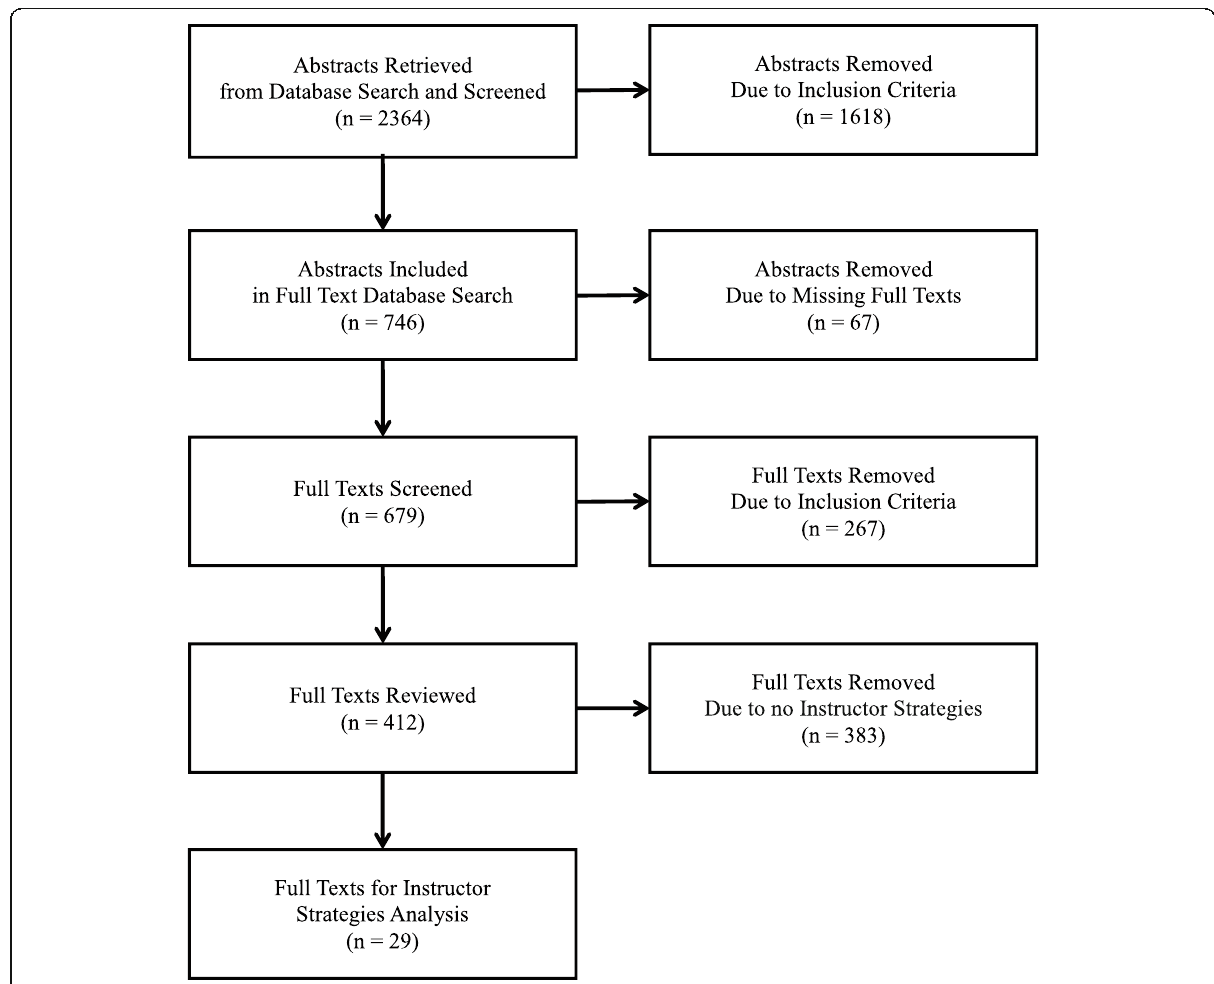
Fig. 1 PRISMA screening overview styled after Liberati et al. (2009) and Passow and Passow